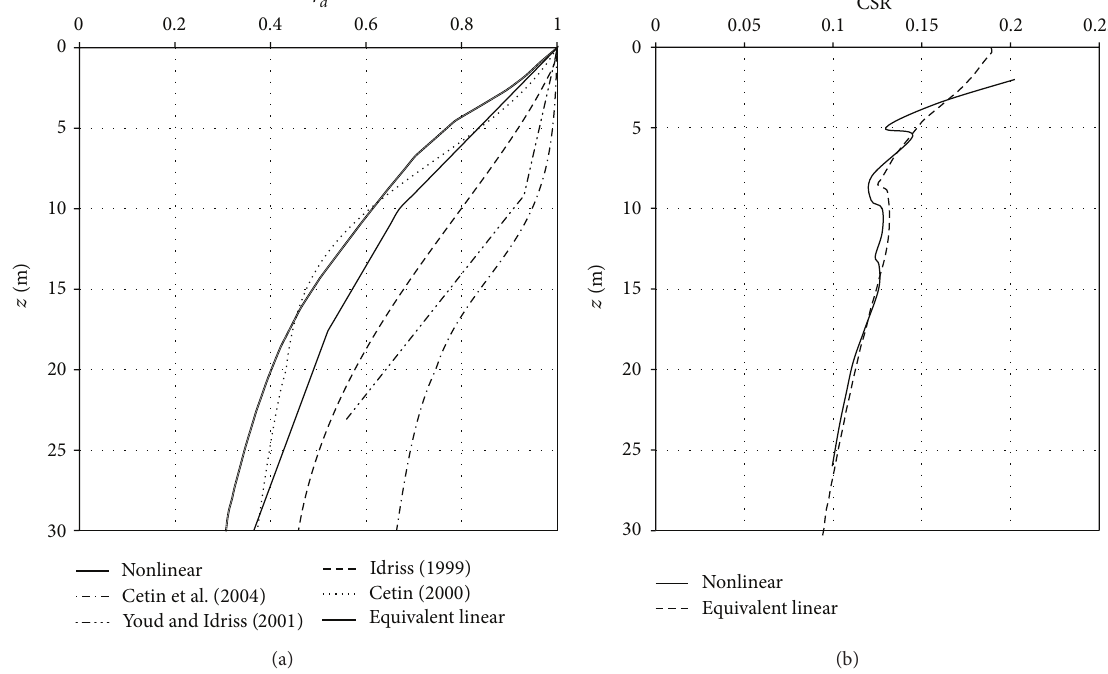
Figure 3: Stress reduction factors computed by different simplified equations, in addition to nonlinear and equivalent linear method (a) and cyclic stress ratio determined by nonlinear and equivalent linear method